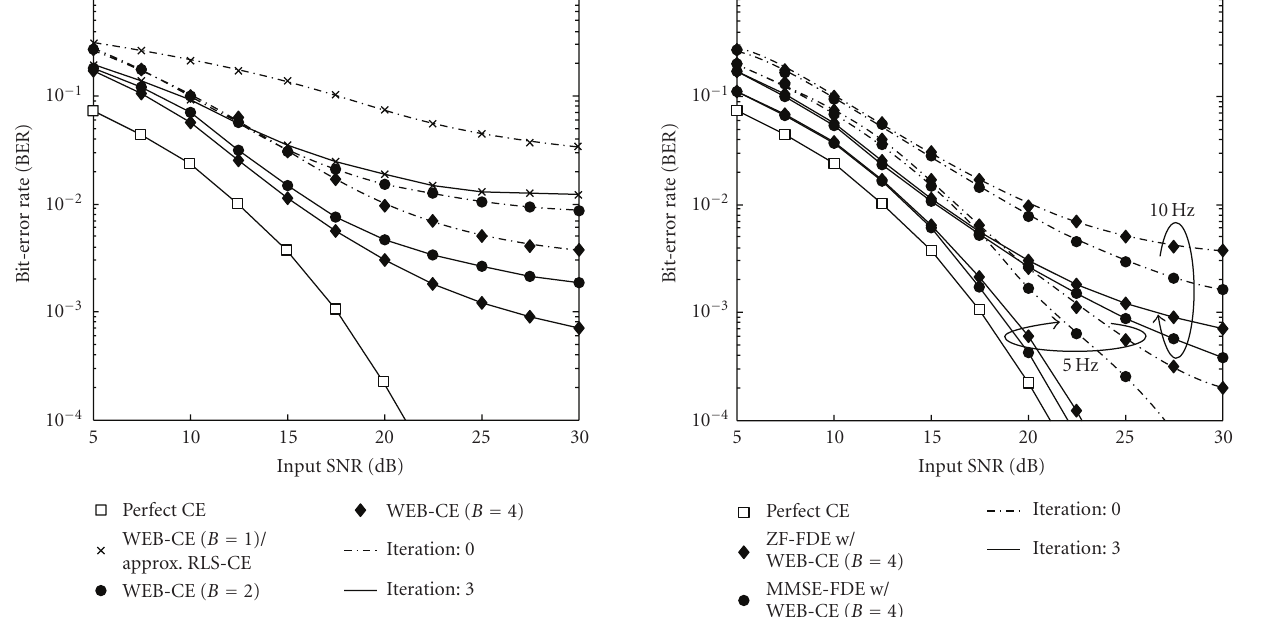
Figure 8: BER performance comparison of ZF-FDE w/WEB-CE ( B = 4) and MMSE-FDE w/WEB-CE ( B = 4) when f d = 5 and 10